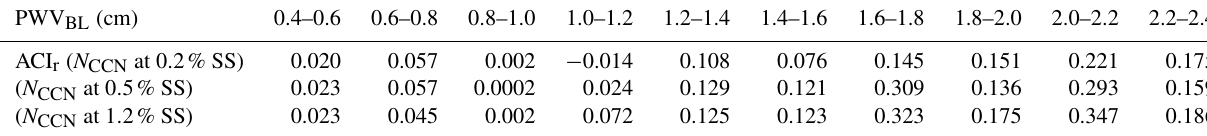
Table 3. ACI r calculated with respect to N CCN theoretically at different supersaturation levels, under all PWV BL conditions. PWV BL (cm)